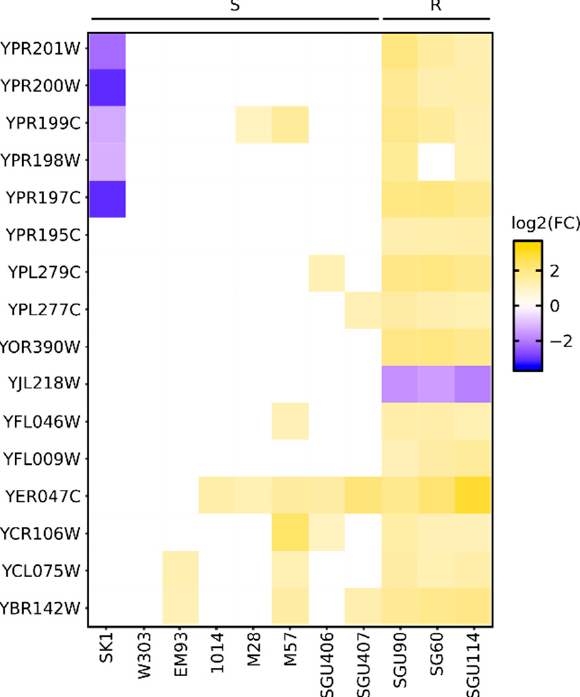
Figure 1. Heatmap of genes differentially represented in resistant and sensitive strains. Only genes differentially represented in arsenic-resistant strains and not differentially represented in sensitive strains, having an opposite logarithm with a two-fold or higher fold change (log2FC) in every sensitive strain or having the same log2FC in at maximum two sensitive strains, are shown. R—strains resistant to arsenic; S—strains sensitive to